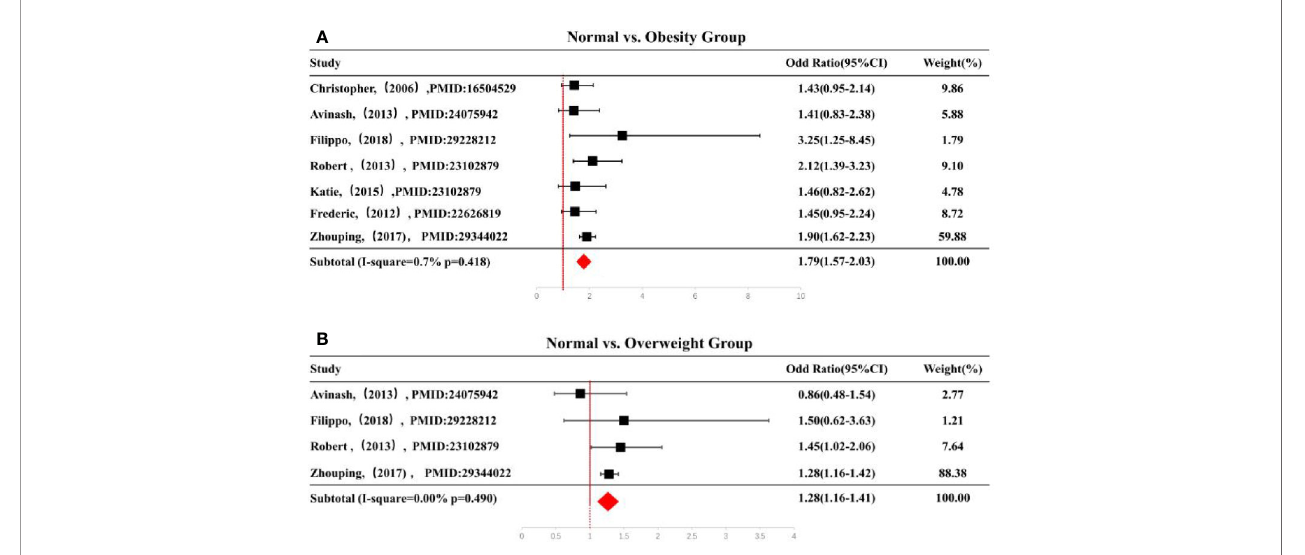
FIGURE 2 | (A) Forest plot of ORs of obesity vs. normal weight and (B) forest plot of ORs of overweight vs. normal weight. Black squares indicate the OR in each study, horizontal lines represent the 95% CI. OR, odd ratio; CI, con fi dence interval; BMI, body mass